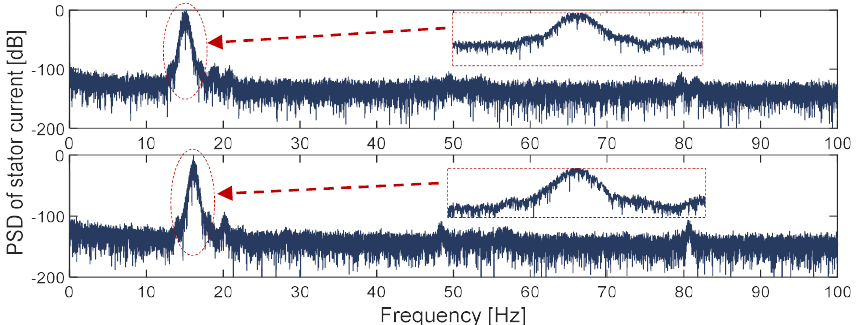
Figure 13. Stator current power spectrum density (PSD): healthy condition (upper PSD) and imbalanced rotor blades (lower PSD).